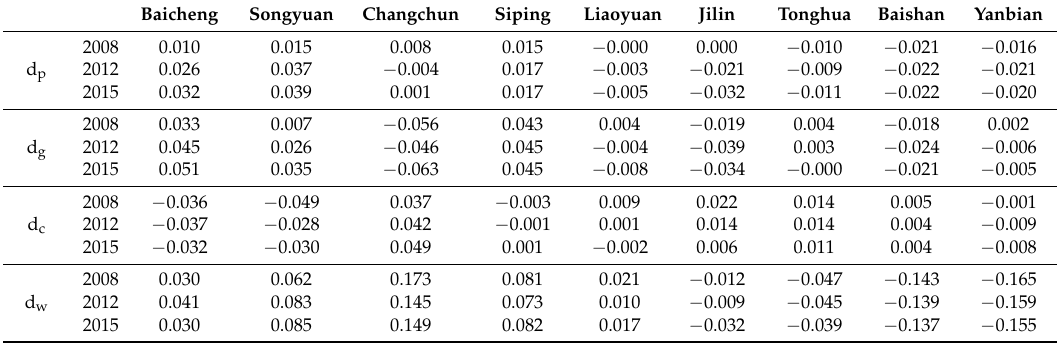
Table 2. Non-absolute value of regional imbalance index between water footprint (WF) and single impact factor (d p , d g , d c , d w ) for nine prefectures in 2008, 2012, and 2015 in Jilin